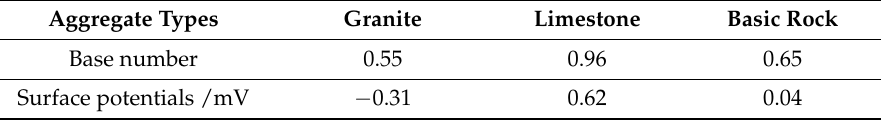
Table 2. The base number and surface potential of aggregates [31].